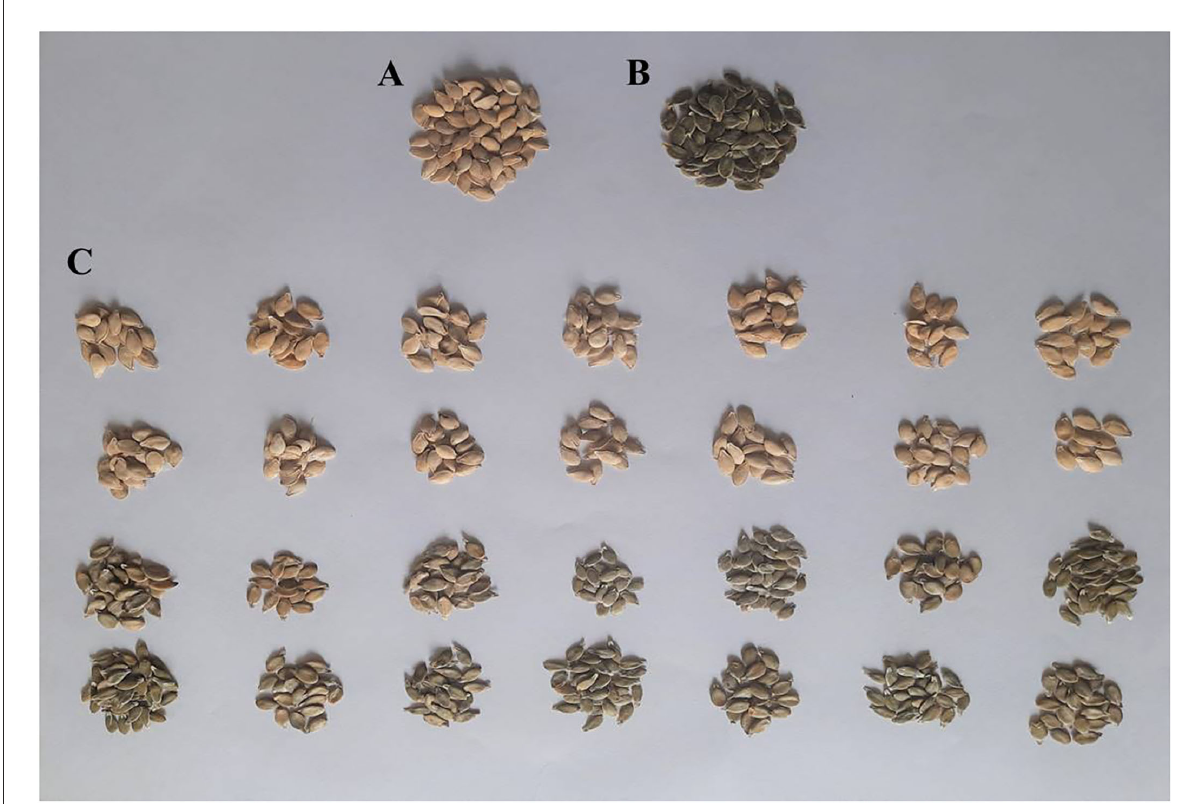
FIGURE1 Seeds of C. pepo parents and bulks used in QTL-seq analysis. (A) Hulled Seeds of HP111; (B) Hull-less seeds of HLP36; (C) F 2 : 3 hulled (1st and 2nd row) and hull-less bulks (3rd and 4th row) of HP111 ×